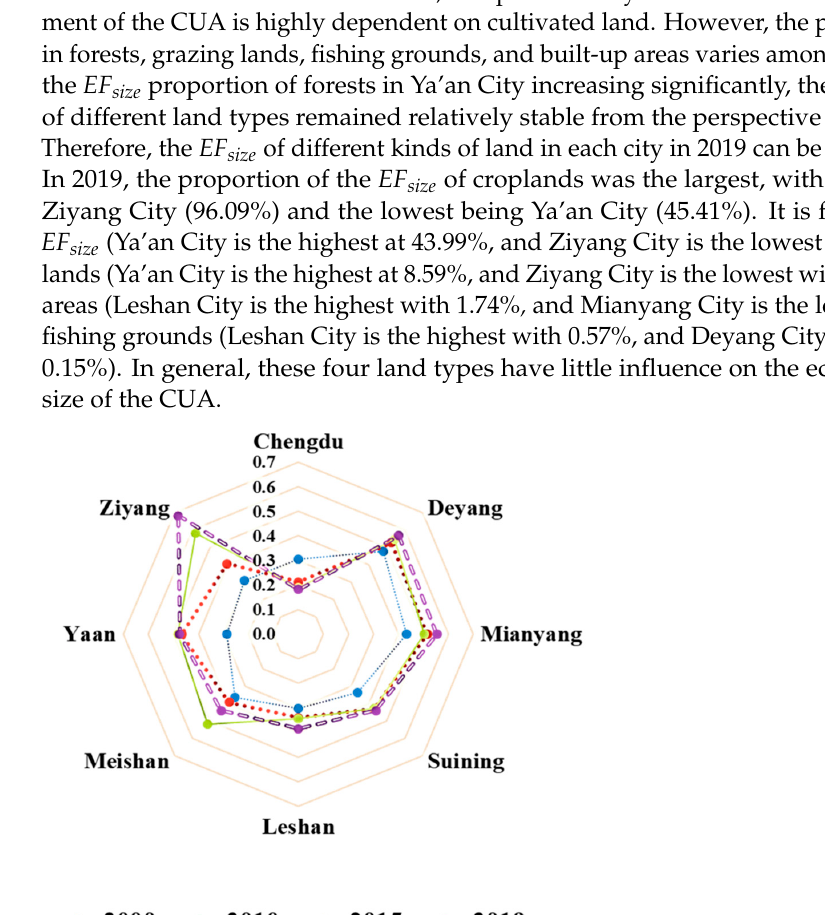
Figure 3. The EF size of the eight cities from 2000 to 2019 (hm 2 ).